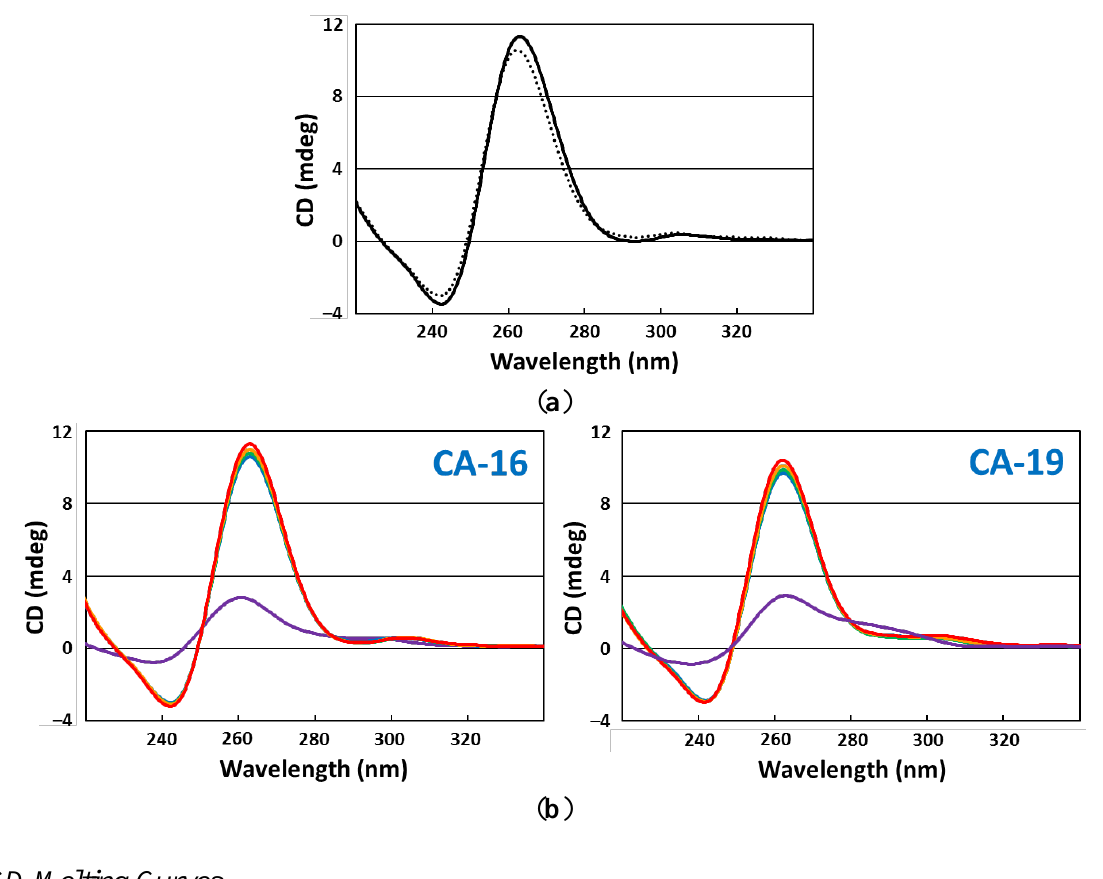
Figure 5. CD spectra for ( a ) CA-16 (solid line) and CA-19 (dashed line) in 10 mM PBS buffer, pH 7.4, and for ( b ) CA-16 (left) and CA-19 (right) in 20 mM Tris-HCl buffer, pH 7.2, and with different K + concentrations: 0 mM (purple), 5 mM (blue), 10 mM (green), 20 mM (orange), and 50 mM